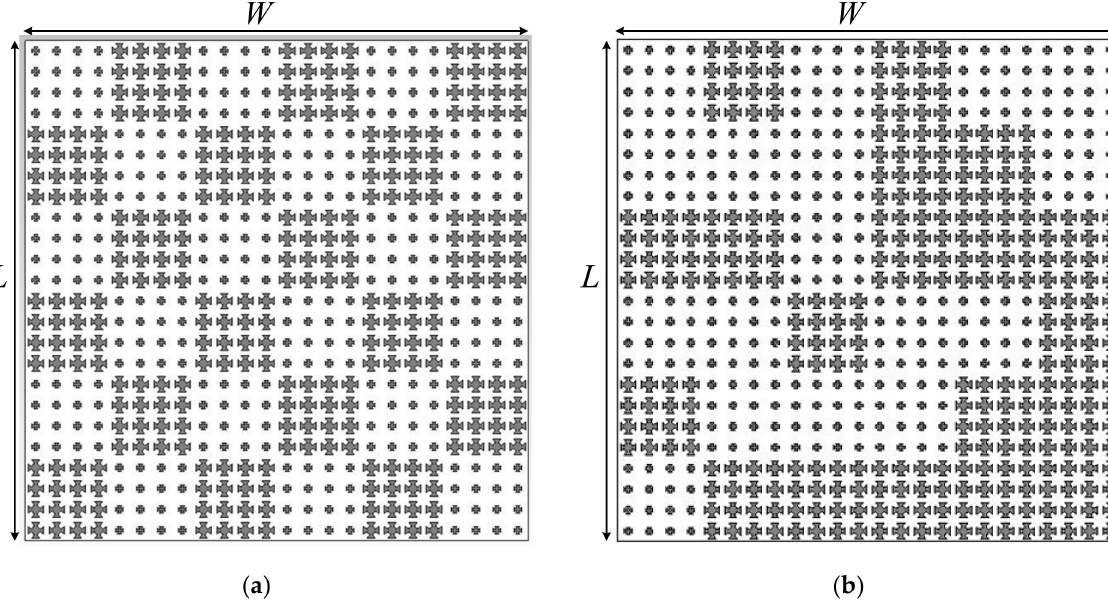
Figure 5. ( a ) Configuration of the checkerboard; ( b ) optimized metasurface